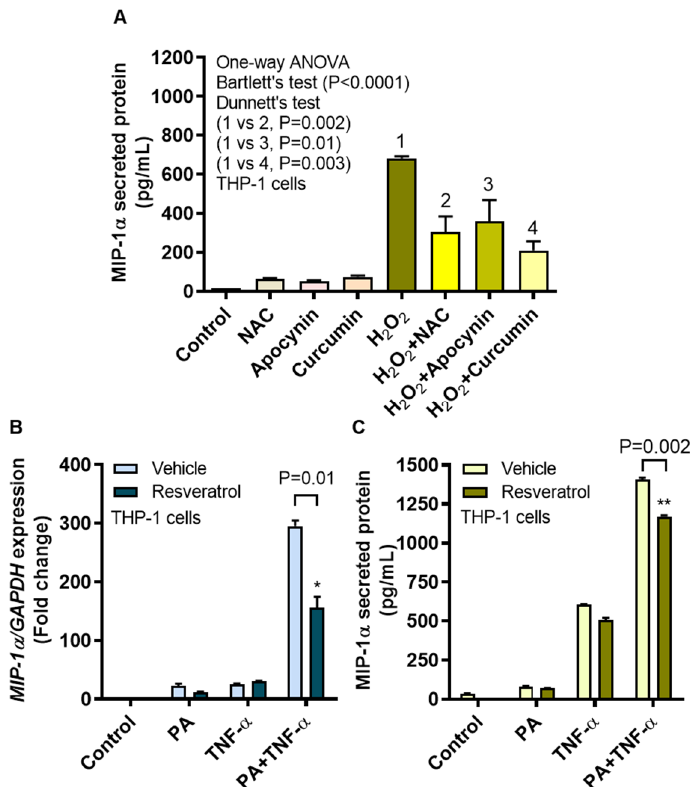
Figure 7. MIP-1α induction by oxidative stress is mitigated by ROS/NF-kB inhibitors. To test whether the MIP-1α induction by oxidative stress was reduced by ROS inhibitors, THP-1 cells were treated with N -acetyl cysteine (NAC), apocynin, or curcumin before stimulation with H 2 O 2 (10 mM for 10 h) and MIP-1α secreted protein expression was measured as described in Section Materials and Methods. To assess the effects of ROS/NF-κB inhibitor on MIP-1α gene and protein expression, cells were pre-treated with resveratrol (5 μM for 30 min) before stimulation with palmitate and/or TNF-α The representative data (mean ± SEM) from three independent determinations with similar results show a significant reduction in ( A ) MIP-1α secreted protein in cells that were treated with NAC ( P = 0.002), apocynin ( P = 0.01), or curcumin ( P = 0.003).The data also show significant reduction in ( B ) MIP-1α mRNA ( P = 0.01) and ( C ) MIP-1α protein ( P = 0.002) expression following resveratrol treatment. * P < 0.05 and ** P < 0.01.